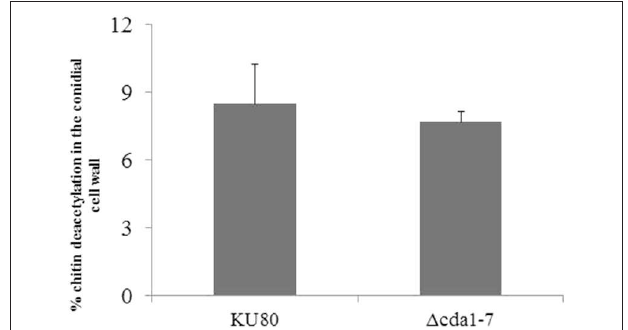
FIGURE 1 | Quantification of glucosamine and N-acetyl glucosamine in the alkali-soluble and -insoluble fractions of mycelial and conidial cell wall. (A) Total amount of glucosamine determined by anhydromannitol quantification after HNO 2 deamination followed by GC. (B) Percentage of deacetylation of chitin in the cell wall.